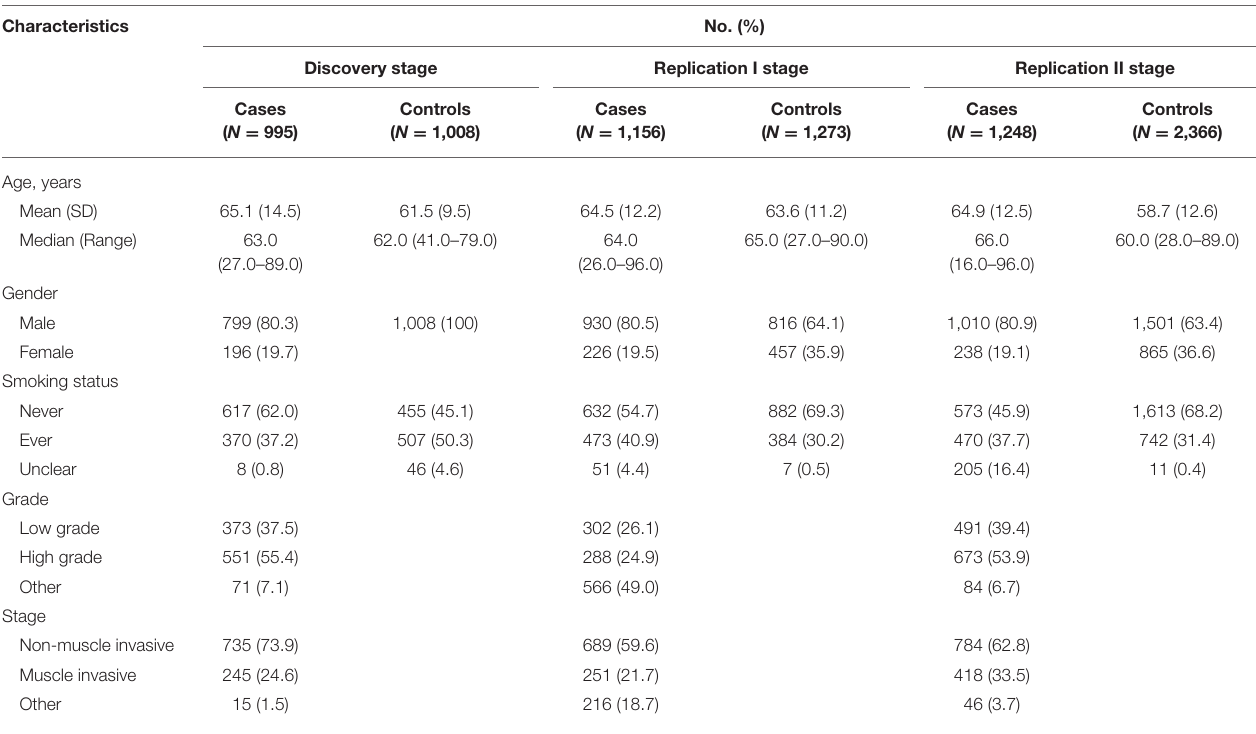
TABLE 1 | Characteristics of subjects analyzed in the discovery and subsequent replication stages.